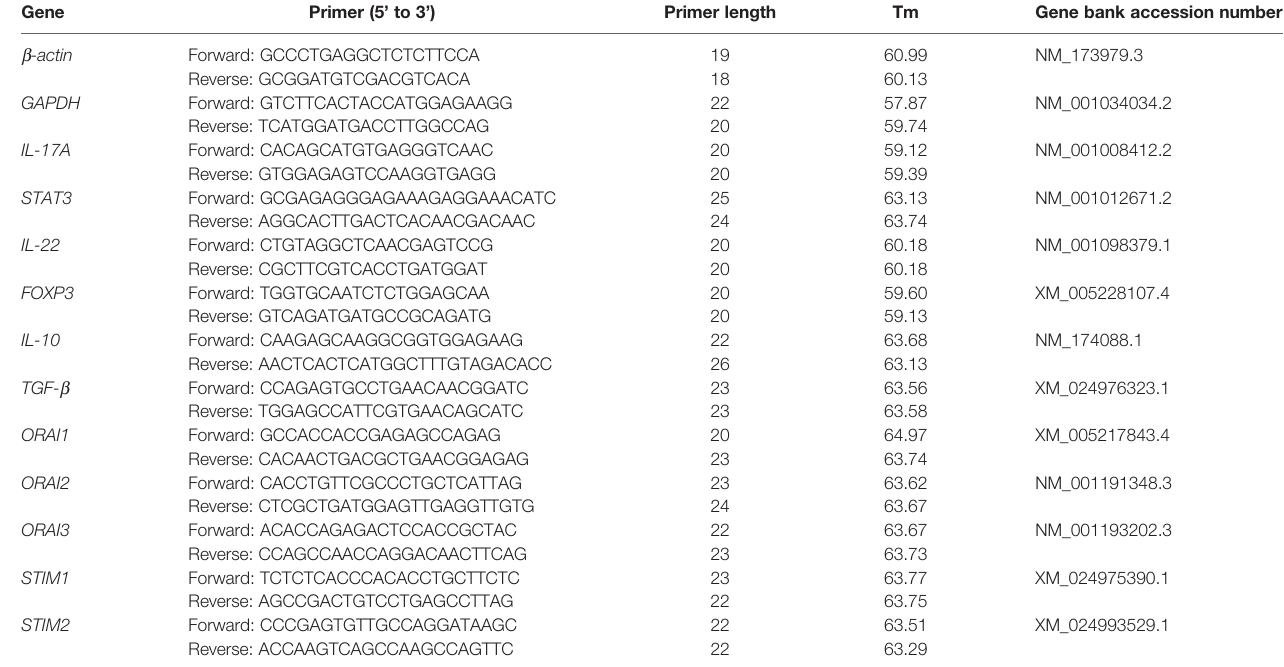
TABLE 3 | Sequences of primers used for real-time PCR ampli fi